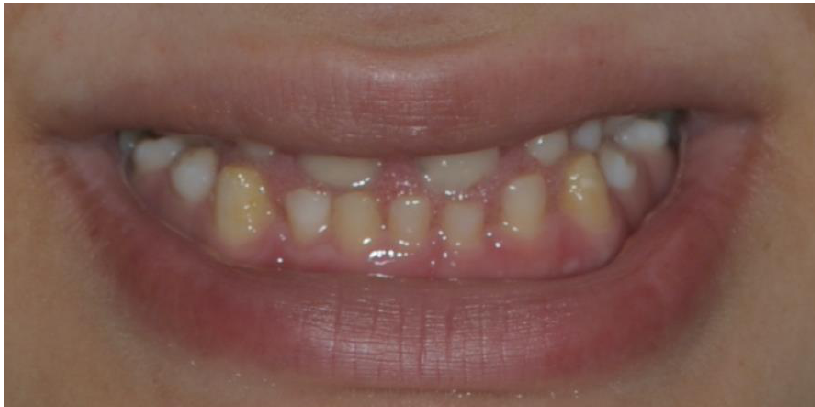
Figure 12. Case 4—Extraoral view of a young patient with multiple dental agenesis.